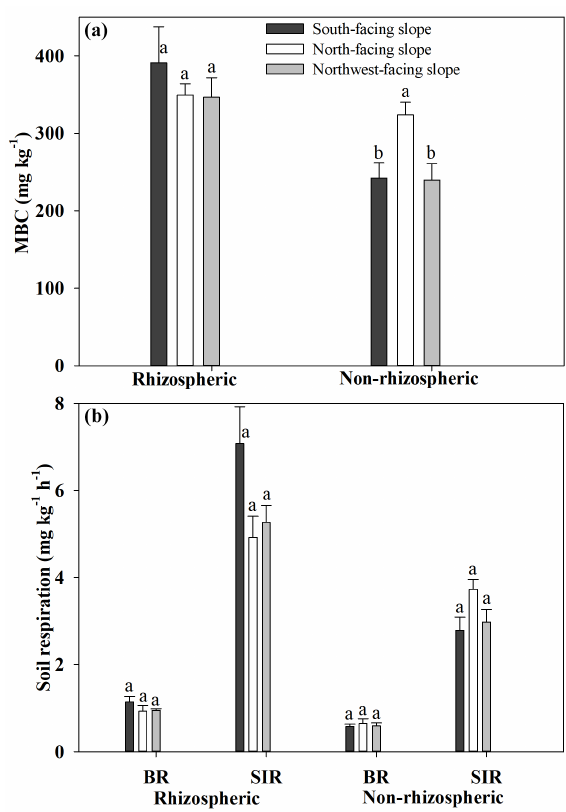
Figure 1. Microbial biomass carbon (MBC) content, basal respi- ration (BR), and substrate-induced respiration (SIR) in the rhizo- spheric and non-rhizospheric soils. Error bars are standard errors ( n = 3). Different letters above the bars indicate significant differ- ences at P = 0 . 05.